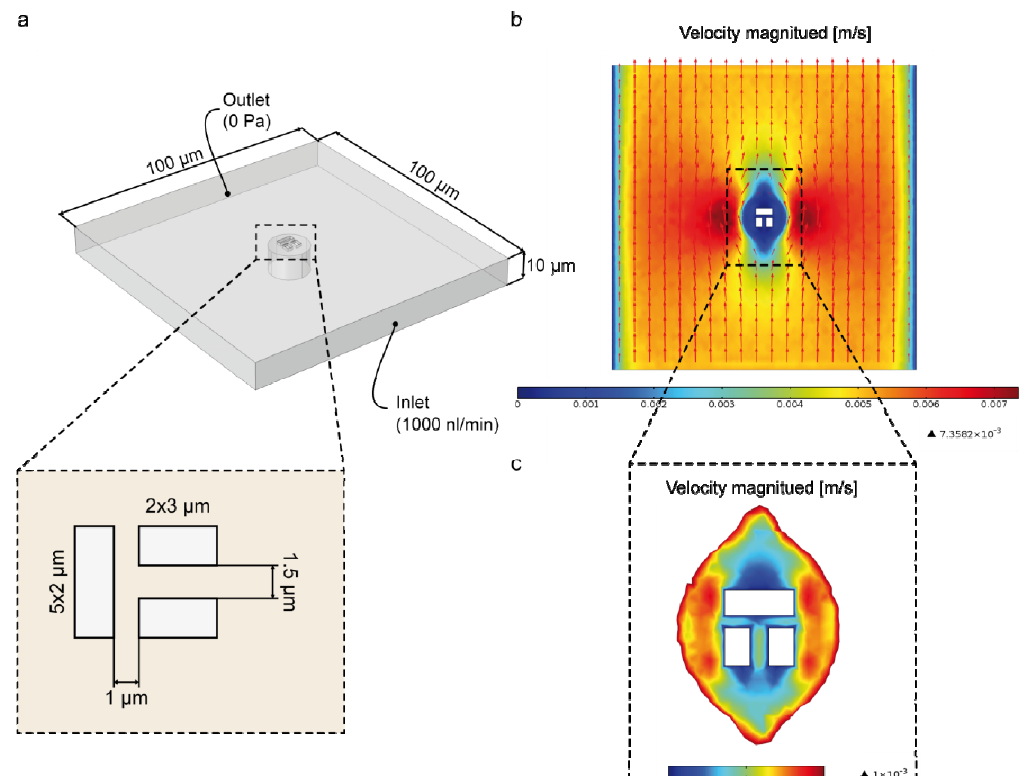
Figure 4. ( a ) Geometry used for numerical simulation with an inlet flow rate of 1000 nL/min, outlet gauge pressure 0 Pa and walls defined as no-slip walls. ( b ) Flow profile and velocity distribution along the whole microfluidic channel. ( c ) Distribution of flow velocity in the shallow region surrounding the trapping